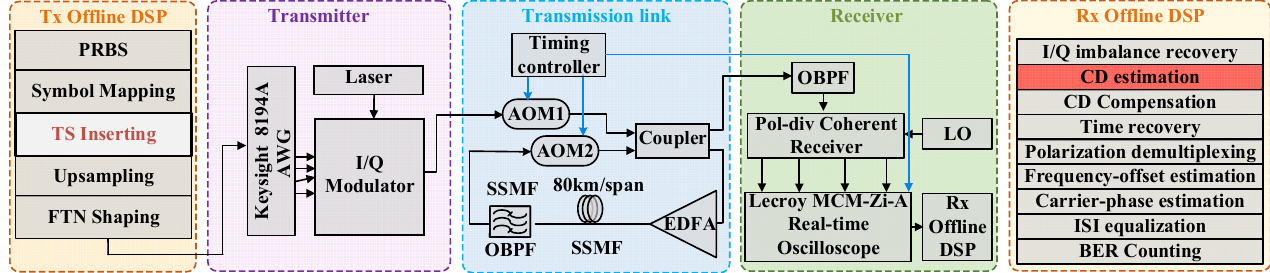
Figure 9. Experimental setup for 60-GBaud FTN DP-QPSK/16QAM coherent transmission systems. Figure 10 shows the total accumulated CD versus the estimated CD under different